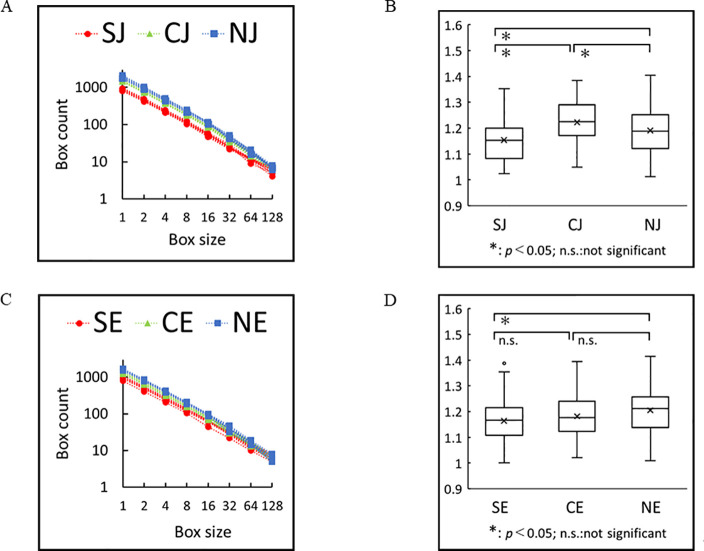
Fractal dimension by box-counting method.(A) Log-log plot of the box size versus box count in Japanese. Normal sentences (NJ), computer generated word salads (CJ) and word salads of patients (SJ) were shown in blue, green and red, respectively. It is worth noting that the box size is an integer number, and in practice, we expect to see the power law behavior for the large box sizes. (B) Differences between all three groups were significant. (P < 0.05) (C) Log-log plot of the box size versus box count in English. Normal sentences (NE), computer generated word salads (CE) and word salads of patients (SE) were shown in blue, green and red, respectively. (D) Differences between (SE) and (NE) were significant. (P < 0.05).